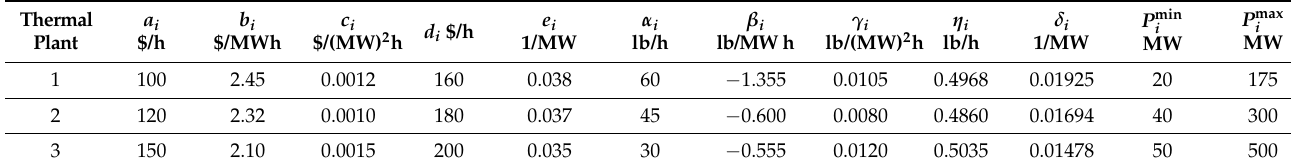
Table A5. Thermal generator data of Test System-I and II.